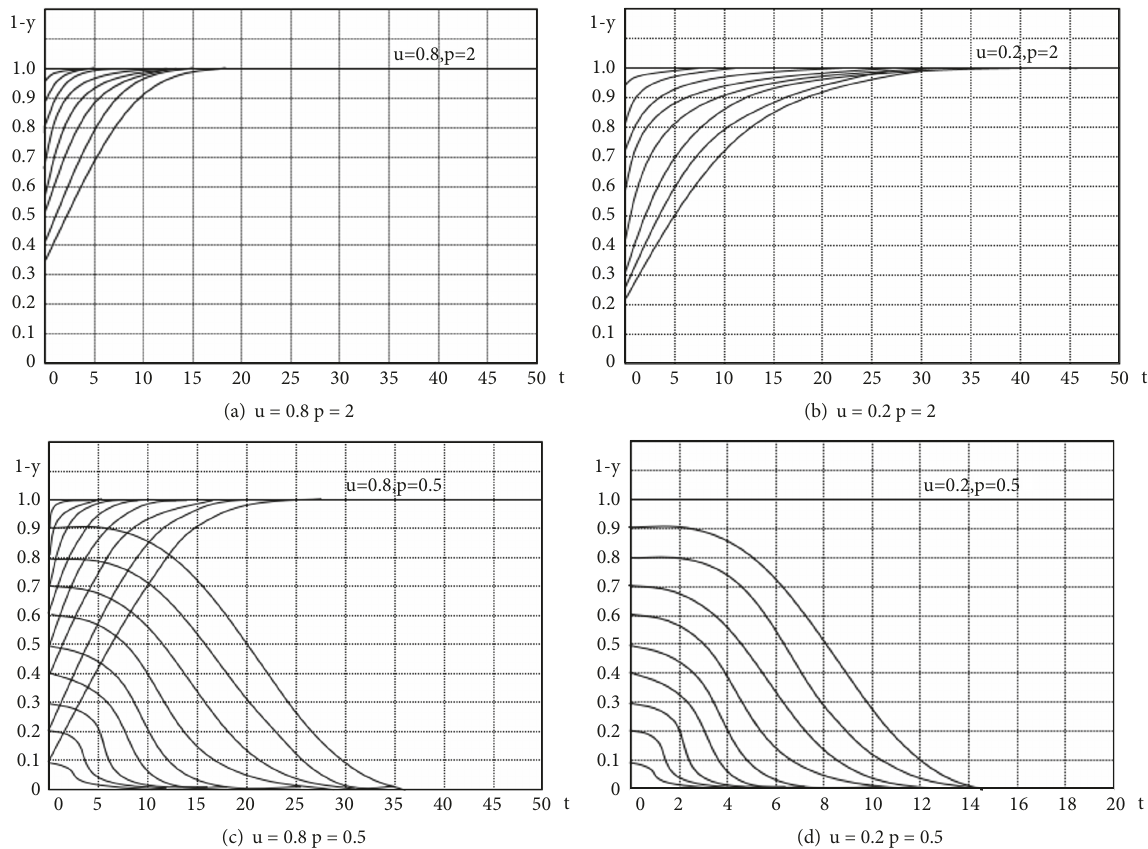
Figure 2: Simulation of the government’s supervision and punishment intensity under different